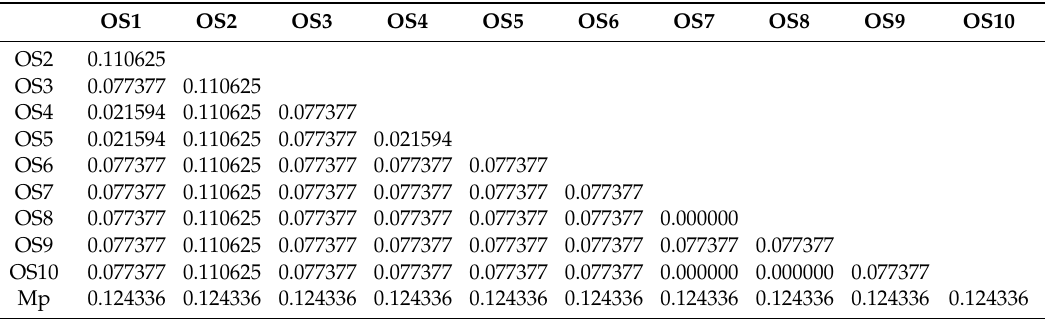
Table 5. Genetic distance based on Jaccard distance coefficient for of 10 random in vitro grown O. stamineus (OS) plantlets.